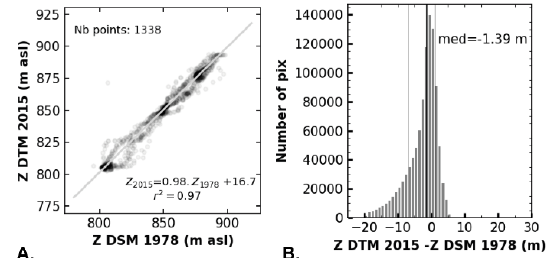
Figure 7. A. Comparison of photogrammetric 1978 (all photos) elevation with lidar of 2015 DTM, the data are from the slice of 20 m x 1000 m located in Figure 1 between reference points p5 and p17. B. Histogram of elevation differences for the complete DTM extent. Without considering the 2.5% extremities of the distribution the median (-1.39 m) and the quantiles at 17% and 83% are respectively (-6.92 m, 1.12 m) figured as black and grey vertical lines.